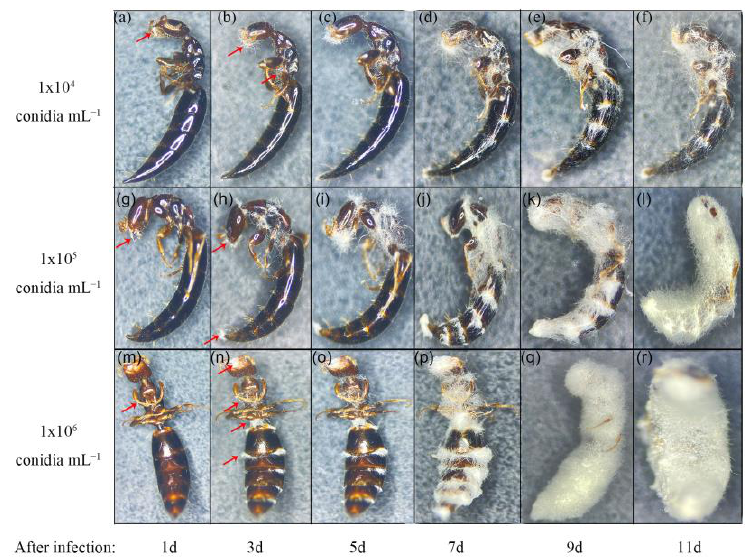
Figure 2. Infestation of pathogens against parental female adults of S. guani under different concen- trations of B. bassiana spore suspensions (red arrow indicates the dead larvae) (a–f: growth of hyphae on the body surface of S. guani at 10 4 conidia mL − 1 B. bassiana suspension; g–l: growth of hyphae on the body surface of S. guani at 10 5 conidia mL − 1 B. bassiana suspension; m–r: growth of hyphae on the body surface of S. guani at 10 6 conidia mL − 1 B. bassiana